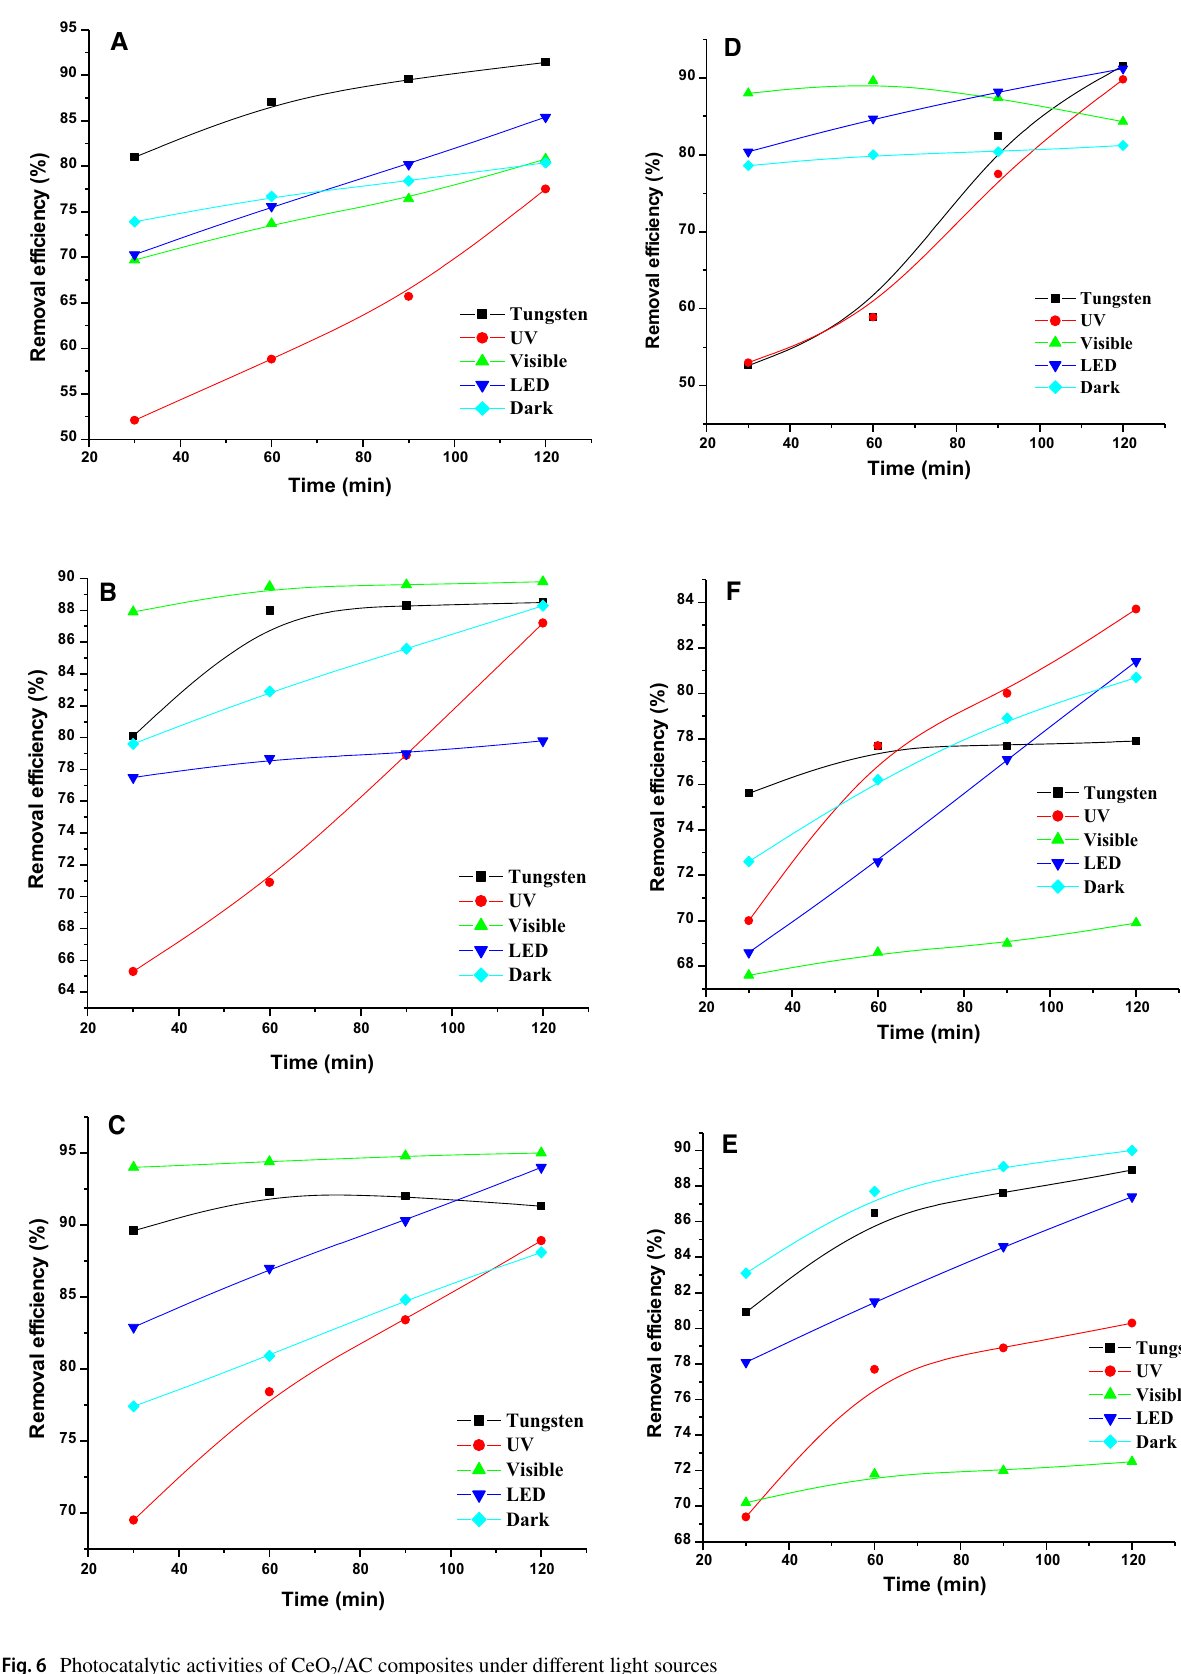
Fig. 6 Photocatalytic activities of CeO 2 /AC composites under different light